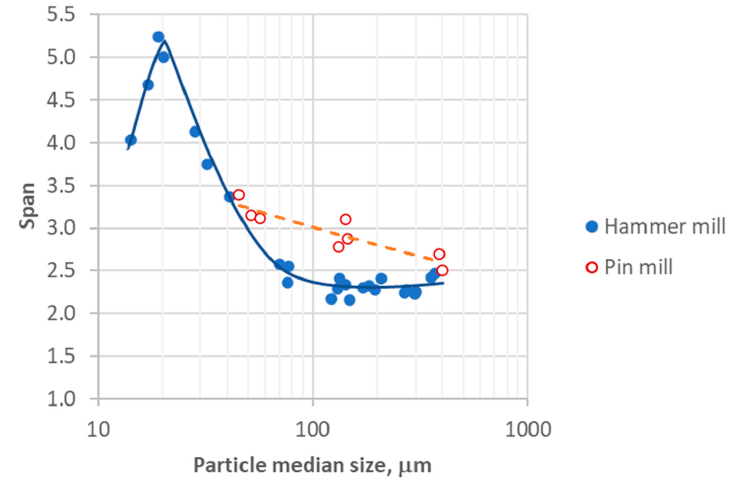
Figure 8. Span as a function of median particle size.